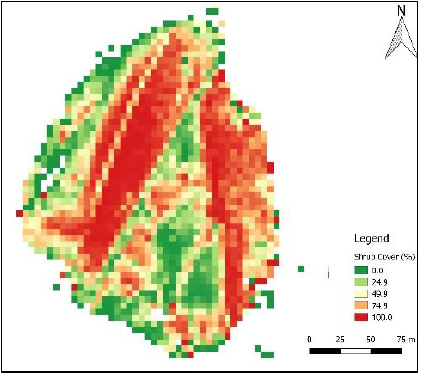
Figure 7. Shrub cover model, generated by the LiDAR point cloud for Dataset 1.